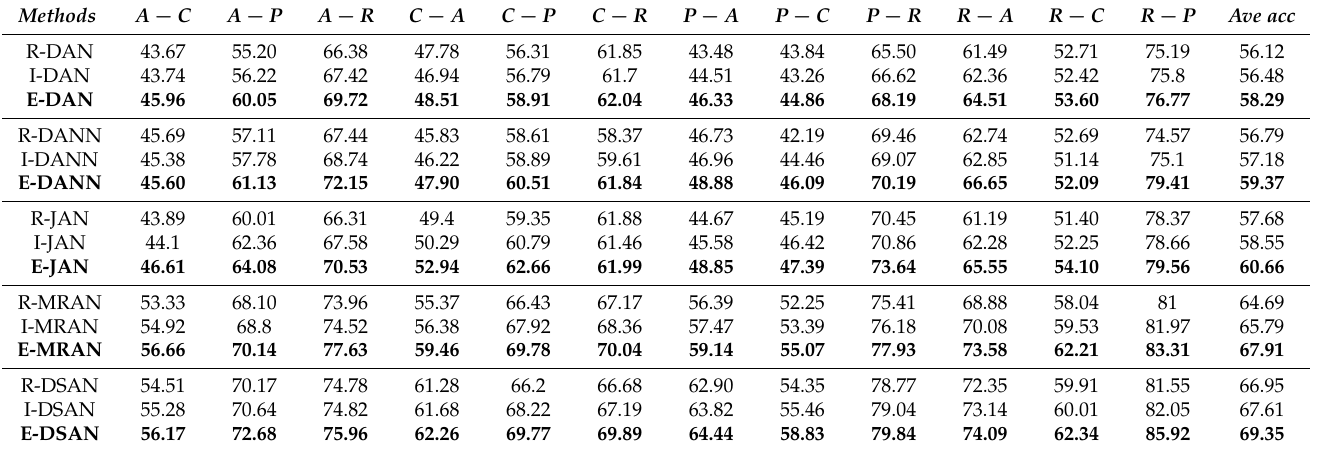
Table 8. Cross-domain image classification accuracies of Office-Home image data sets generated by ensemble strategy with improved DPP sampling (“ E − ∗ ”), information gain (“ I − ∗ ”) and random sampling (“ R − ∗